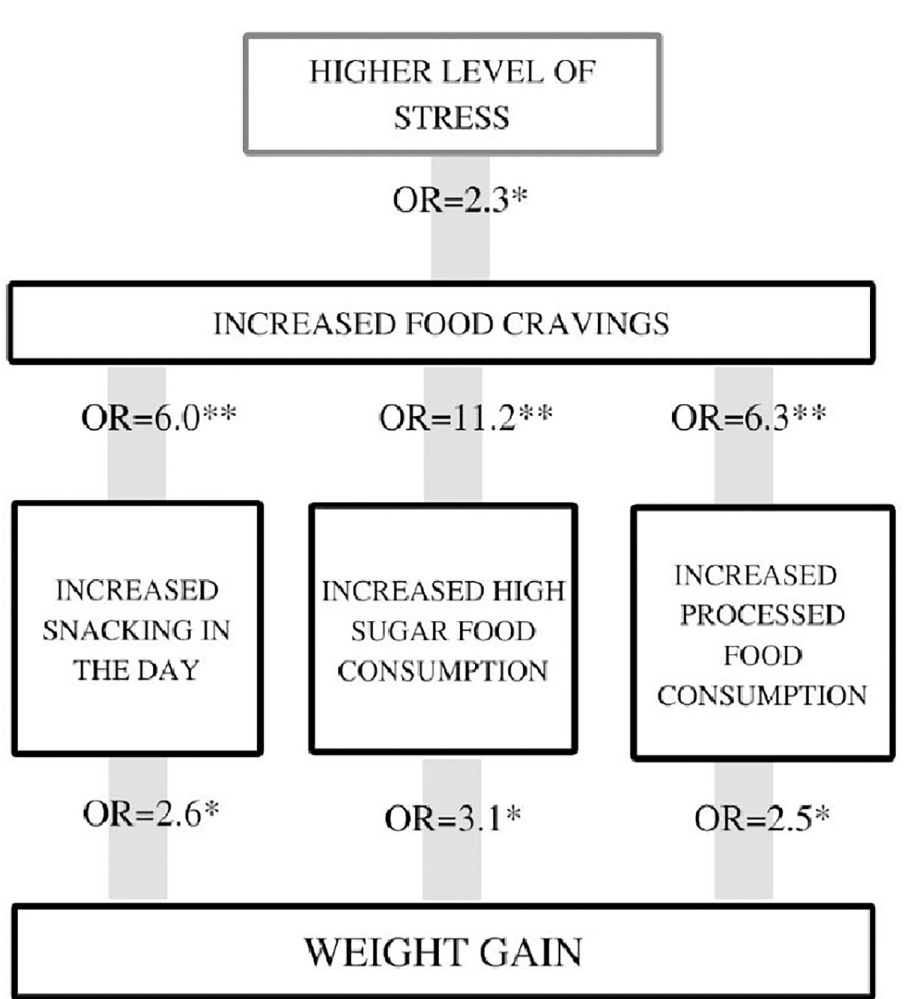
Fig 1. Summary of the key statistical analyses from the study. n = 179; OR = odds ratio; * = p < 0.05; ** = p < 0.001.